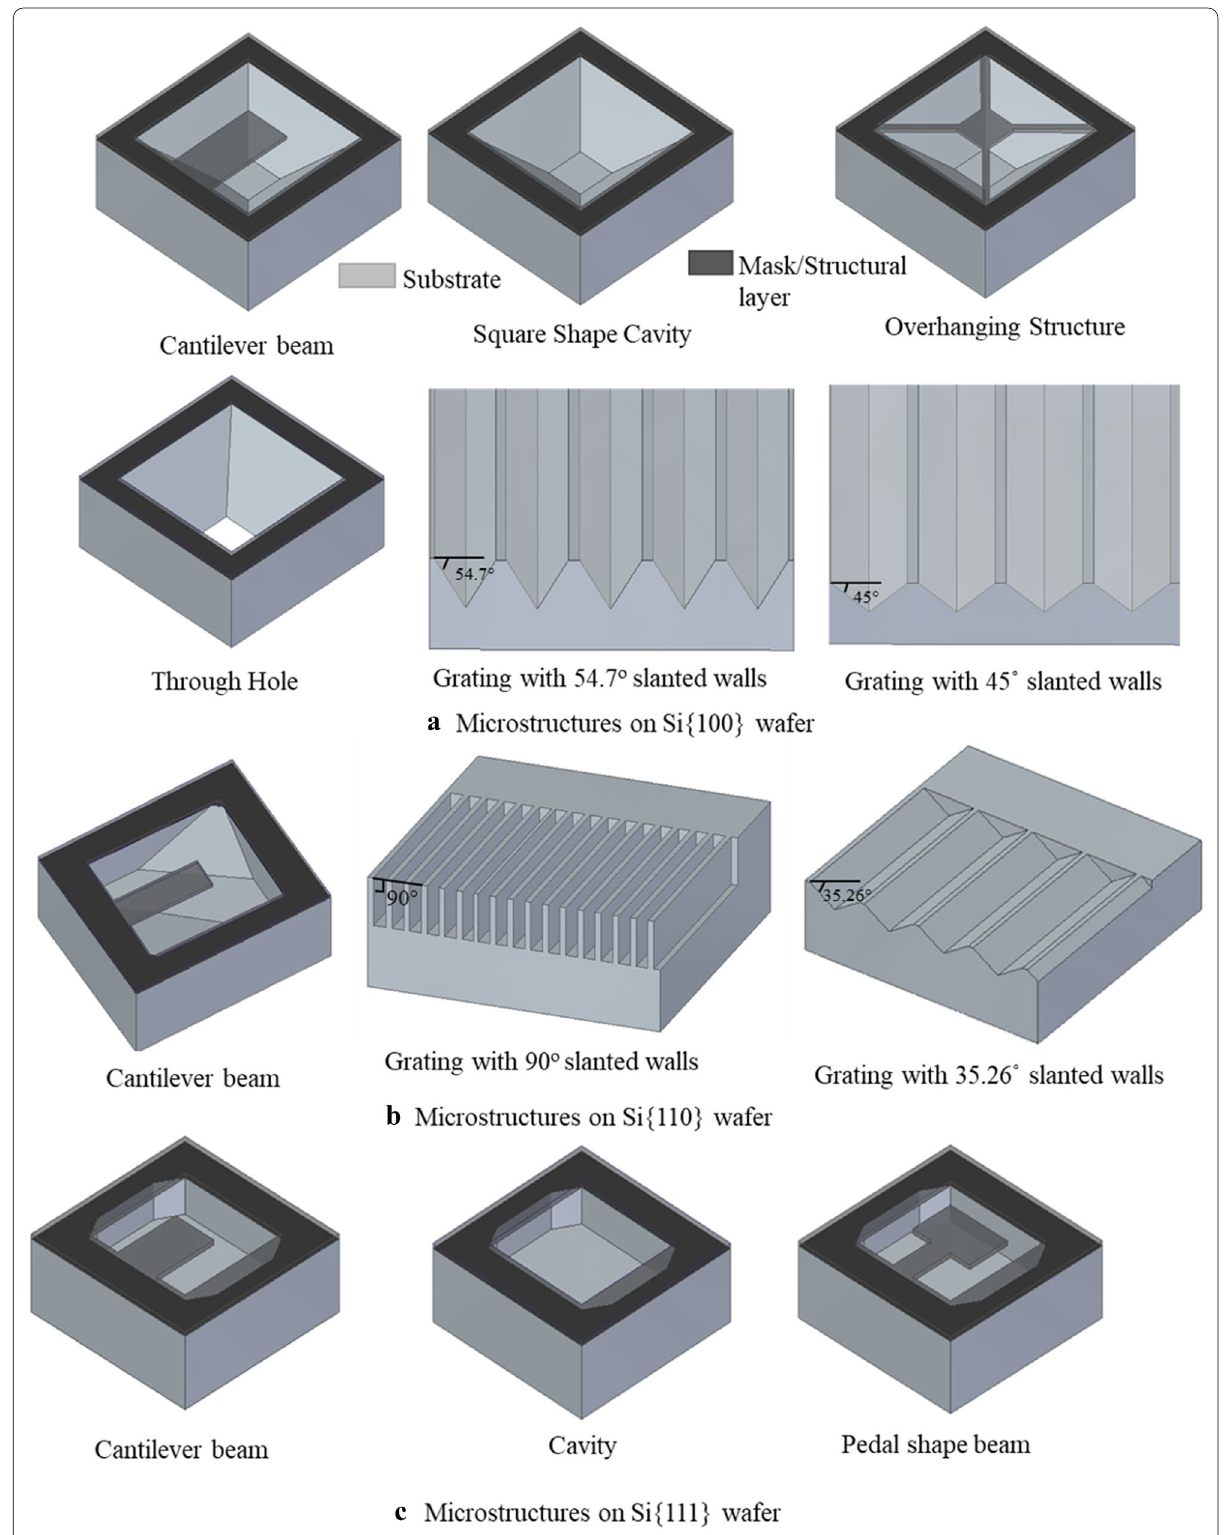
Fig. 2 Schematic views of microstructures fabricated on silicon a Si{100}, b Si{110} and c Si{111} wafer using wet anisotropic